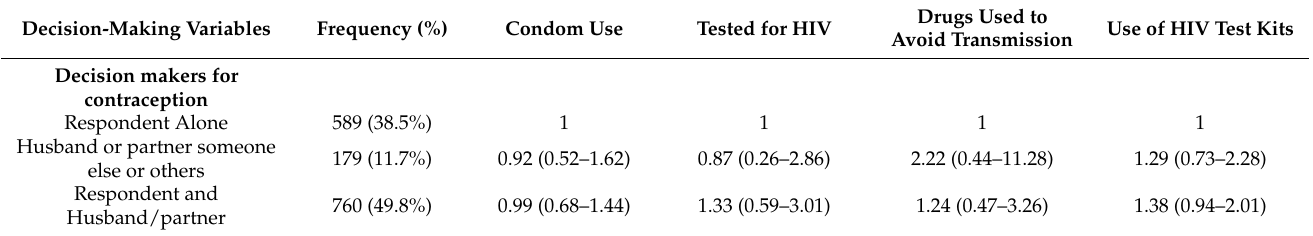
Table 3. Relationship between HIV prevention behavior and autonomy of women in South